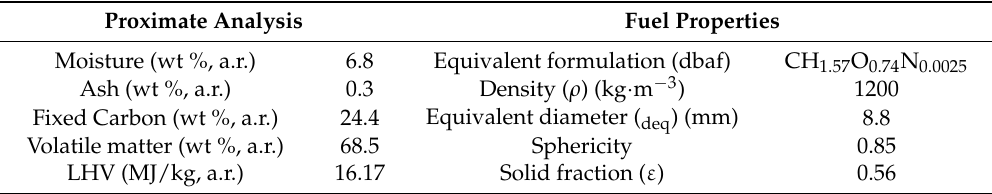
Table 2. Composition and properties of the fuel.